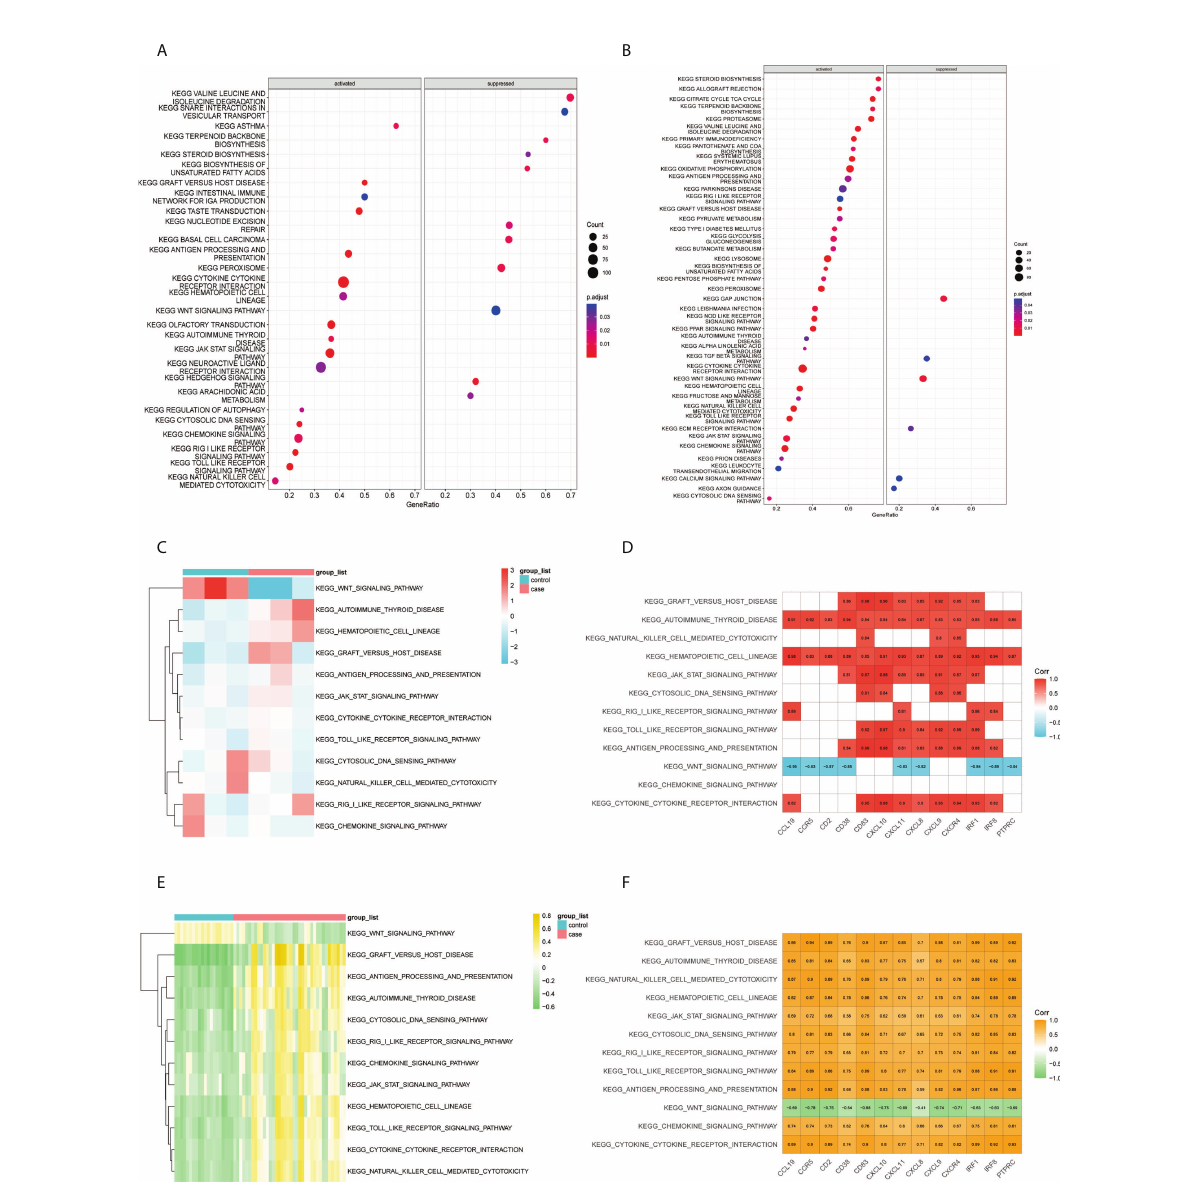
FIGURE 6 Correlation between pathways and hub genes: (A) GSEA – KEGG results of FFA, (B) GSEA – KEGG results of rosacea, (C) GSVA scores of the common GSEA pathways in FFA, (D) correlation heat map between the expression levels of hub genes and GSVA scores of the common pathways in FFA, (E) GSVA scores of FFA in common GSEA pathways, and (F) correlation heat map between the expression levels of hub genes and GSVA scores of the common pathways in rosacea. GSVA, gene set variation analysis; GSEA, gene set enrichment analysis; KEGG, Kyoto Encyclopedia of Genes and